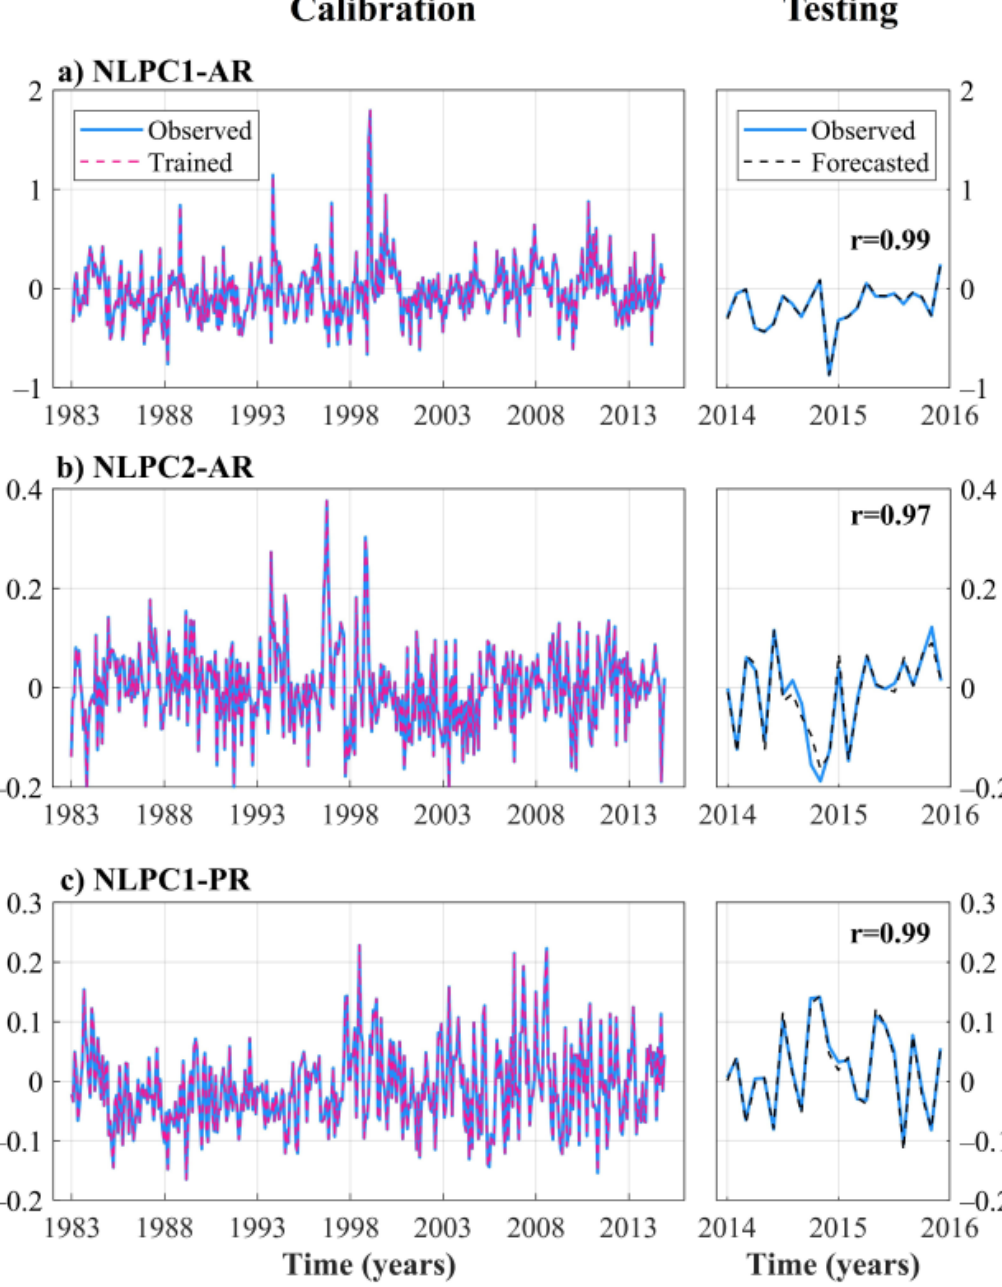
Figure 8. Results of Simplified-NNARMAX models for calibration and testing period: ( a ) NLPC1-AR, ( b ) NLPC2-AR, and ( c ) NLPC1-PR.